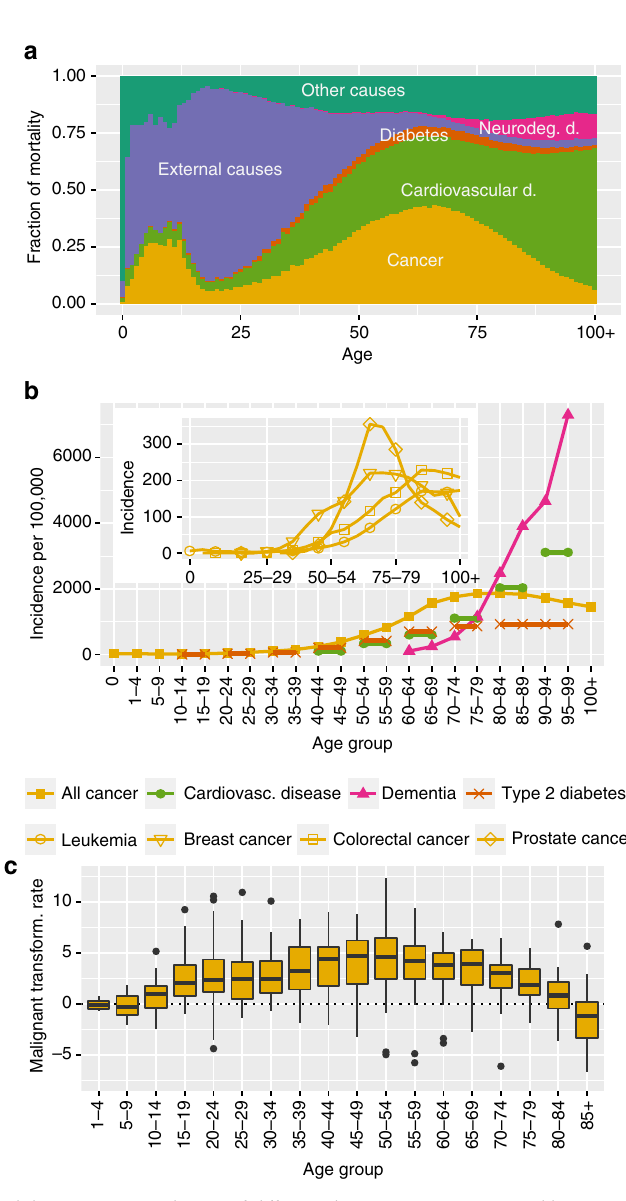
Fig. 1 Epidemiology of ageing-associated diseases. a Contribution of different disease categories to total human mortality (Supplementary Note 1). b First diagnosis (incidence) of ageing-associated diseases and several cancer types (inset) across age groups. Lines across several age groups indicate cases in which only data combining several age groups was available (Supplementary Note 1). c Malignant transformation rates across 34 types of cancer across age groups. The center line corresponds to the median, box limits to 25th and 75th percentiles and whiskers to 1.5 times the interquartile